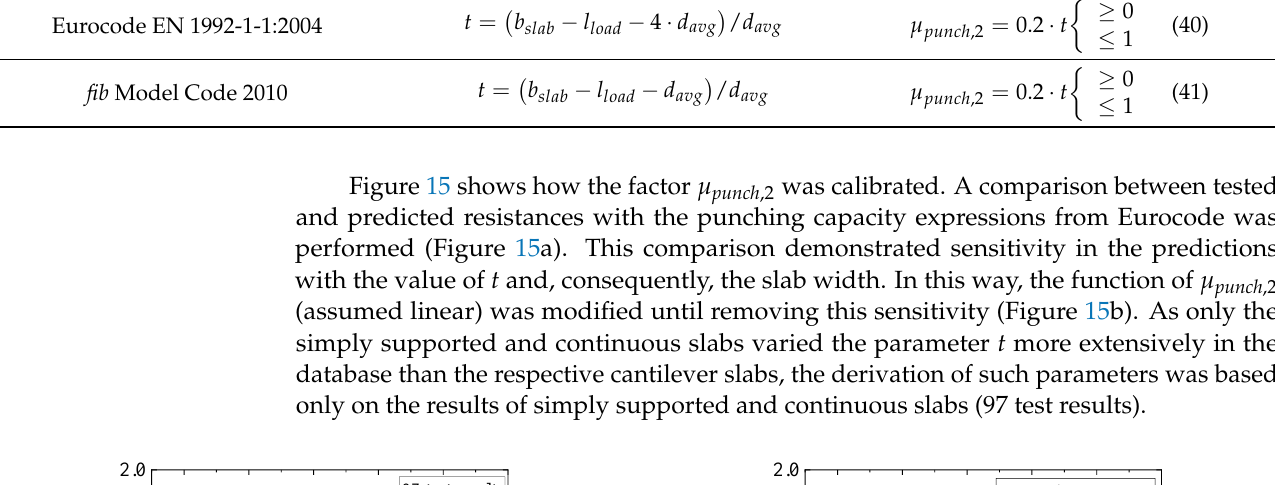
Table 3. Factor µ punch ,2 for EN 1992-1-1:2004 and fib Model Code 2010. Code Parameter